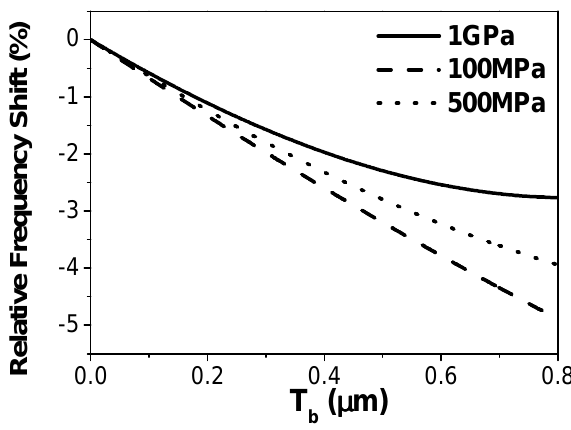
Figure 6. Theoretical calculation of the frequency shift as a function of the adsorbate thickness for three different values of the Young’s Modulus: 1Gpa (solid line), 100 Mpa (dashed line) and 500 Mpa (dotted